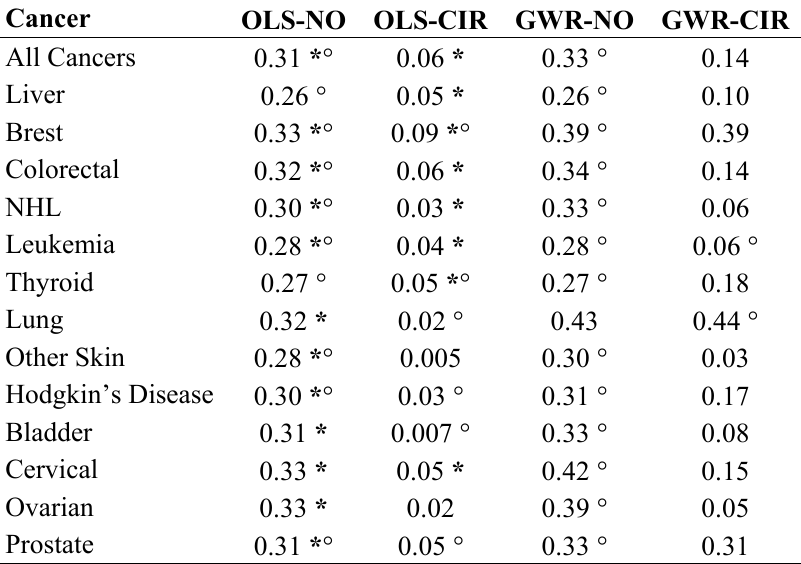
and the most common cancers at the governorate level. 2